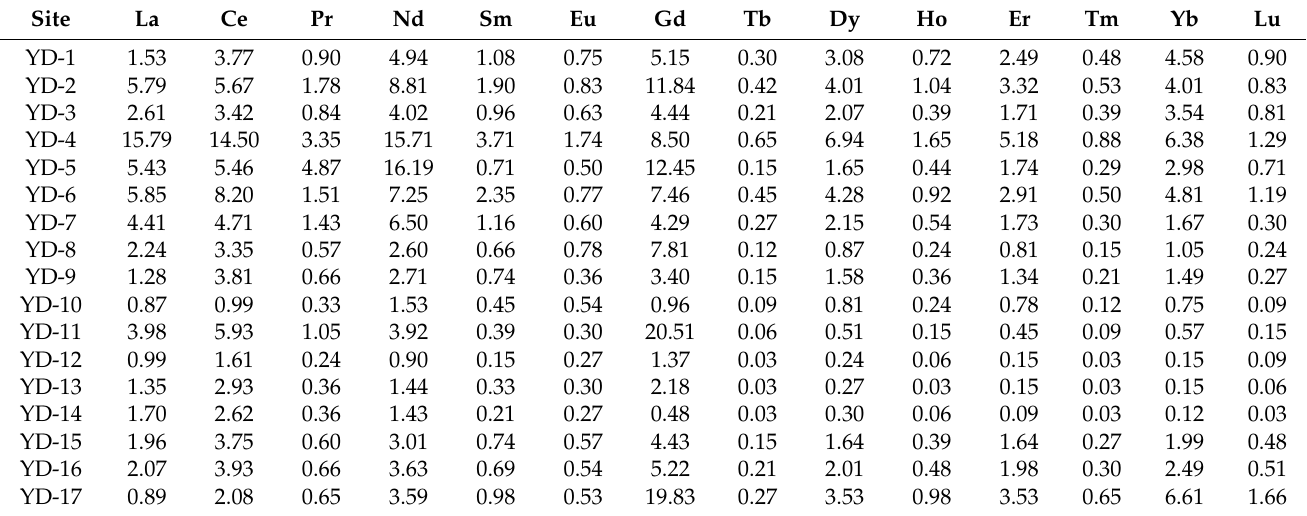
Table 1. Dissolved REE contents in the Yongding River (in